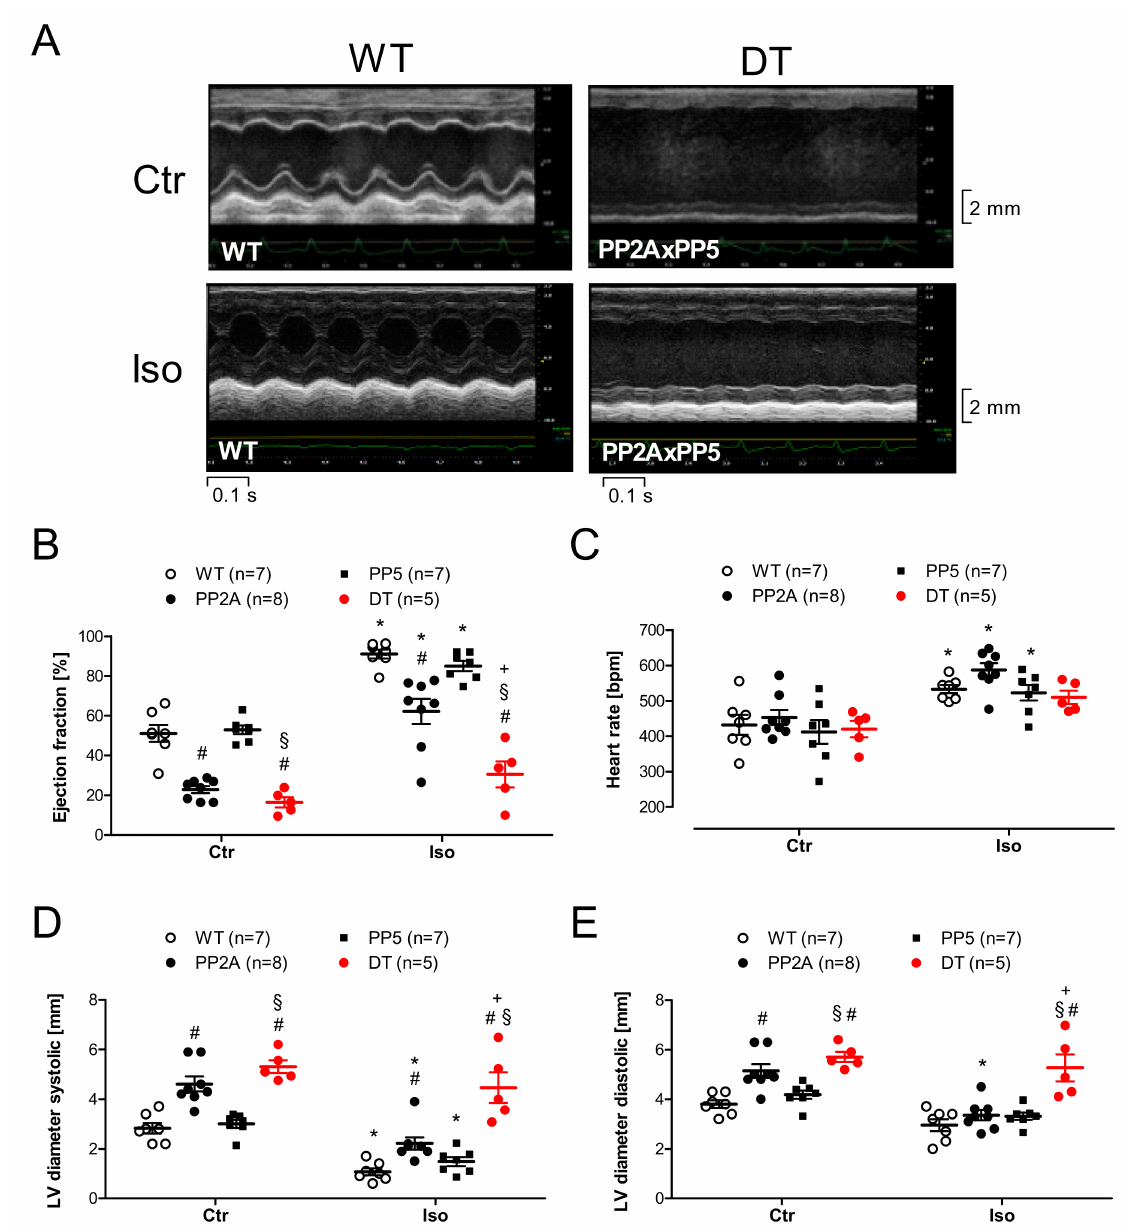
Figure 7. M-mode echocardiography with original recording under basal conditions (Ctr) and after isoproterenol (Iso) in the young mice (age group I). ( A ): Original M-mode recording of WT and DT in young mice; ( B ): Ejection fraction; ( C ): Heart rate; ( D ): Left ventricular (LV) systolic diameter; ( E ): Left ventricular (LV) diastolic diameter; # p < 0.05 vs. WT; + p < 0.05 vs. PP2A; § p < 0.05 vs. PP5; * p < 0.05 vs. Ctr; n =